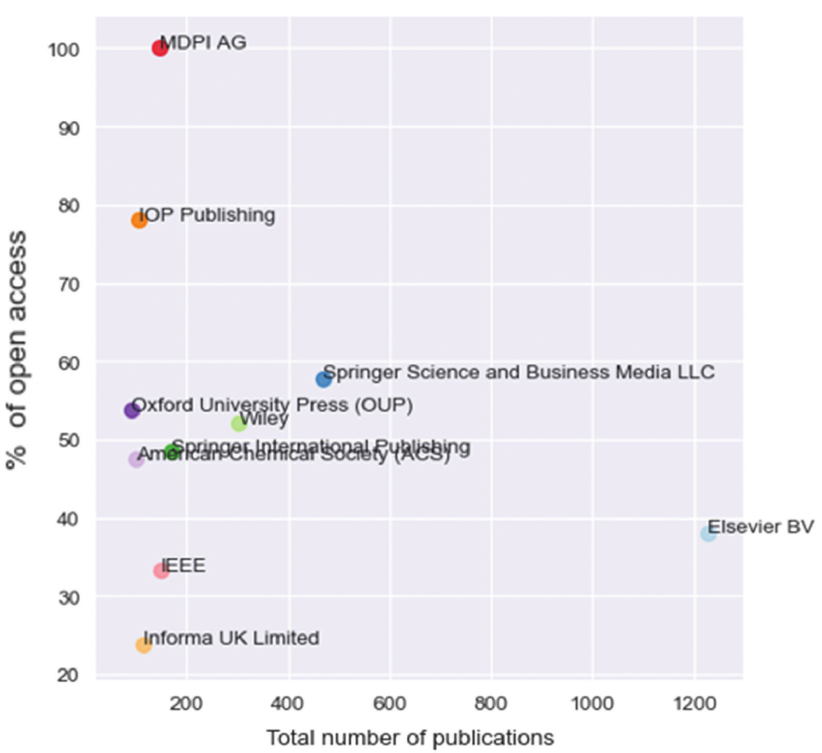
Fig. 5: Open access to publications by publisher or platform related to the number of publications in